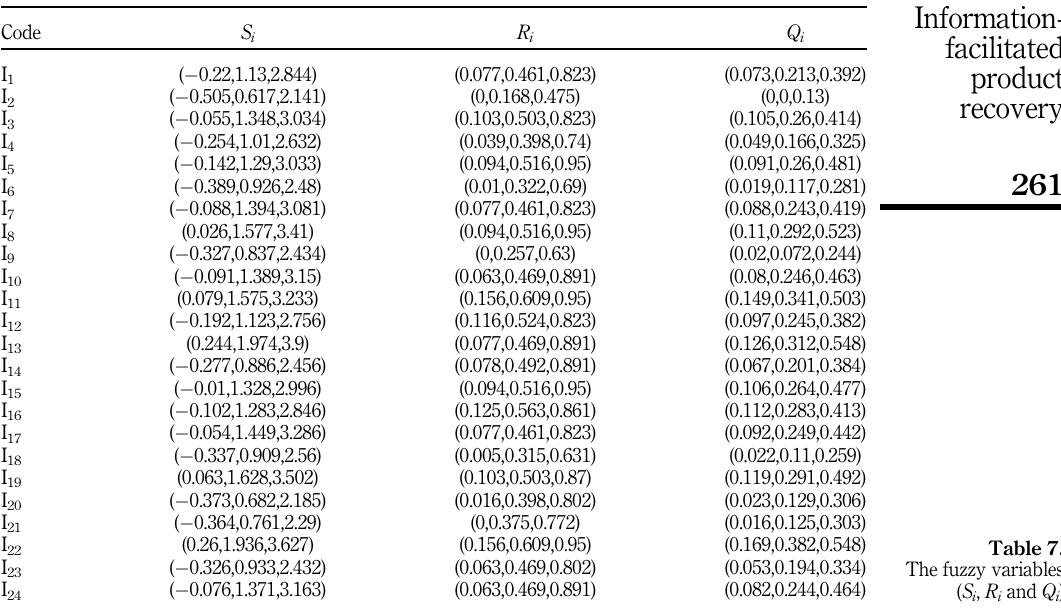
Table 7. The fuzzy